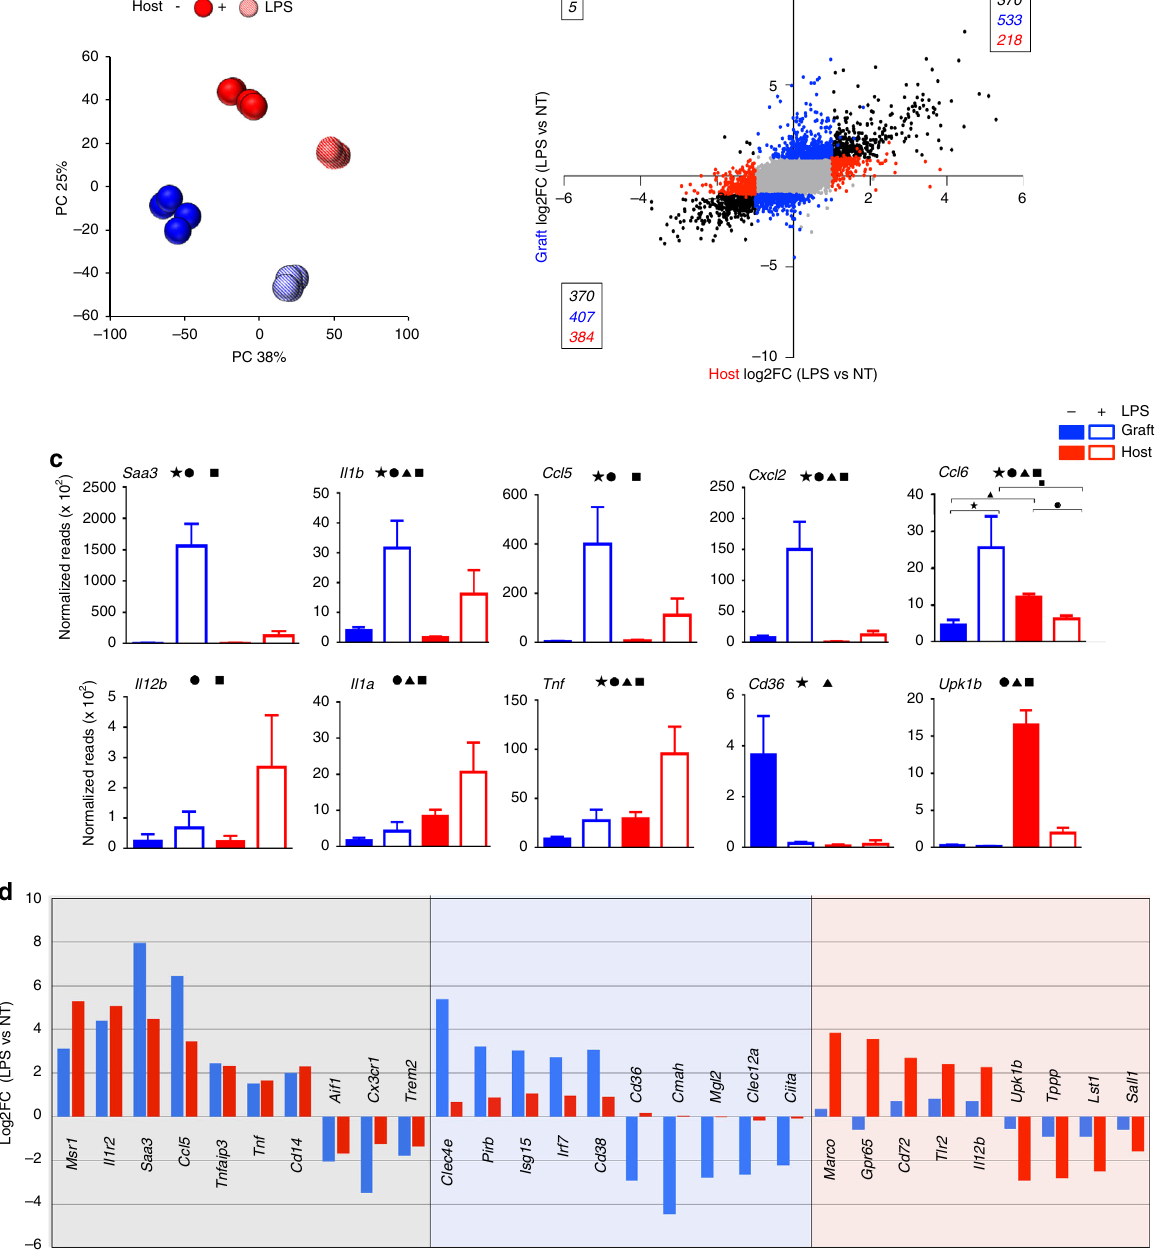
Fig. 5 Distinct LPS responses of engrafted macrophages and host microglia. a PC analysis of RNA seq data of graft and host microglia in steady state and 12 h post LPS. b Expression analysis of grafted cells and host microglia in steady state and 12 h post LPS by RNA seq. c Examples of genes expression of graft and host microglia in steady state and 12 h post LPS. Signi fi cance is indicated by the symbols ( p -value < 0.05), or lack thereof ( p -value>0.05). See Ccl6 plot (top right) for symbol to condition conversion. d Fold expression change of selected genes signi fi cantly different (absolute value of log2FC> 1, p - value < 0.05) following challenge in grafted cells (middle) or host microglia (right), as well as genes displaying comparable up- and downregulation in both engrafted cells and host microglia (left). Source data are provided as a Source Data fi